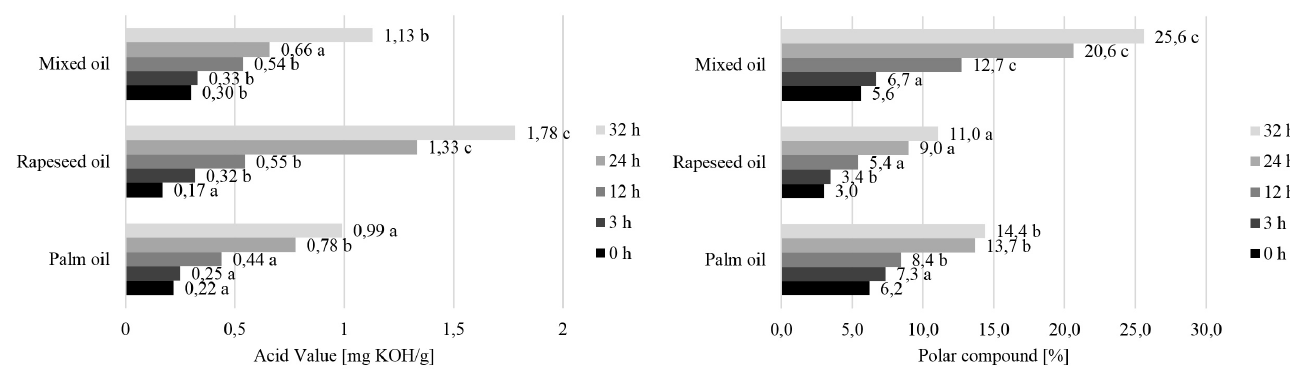
Fig. 1: AV changes in oil during frying. Fig. 3: Polar compounds changes in oil during